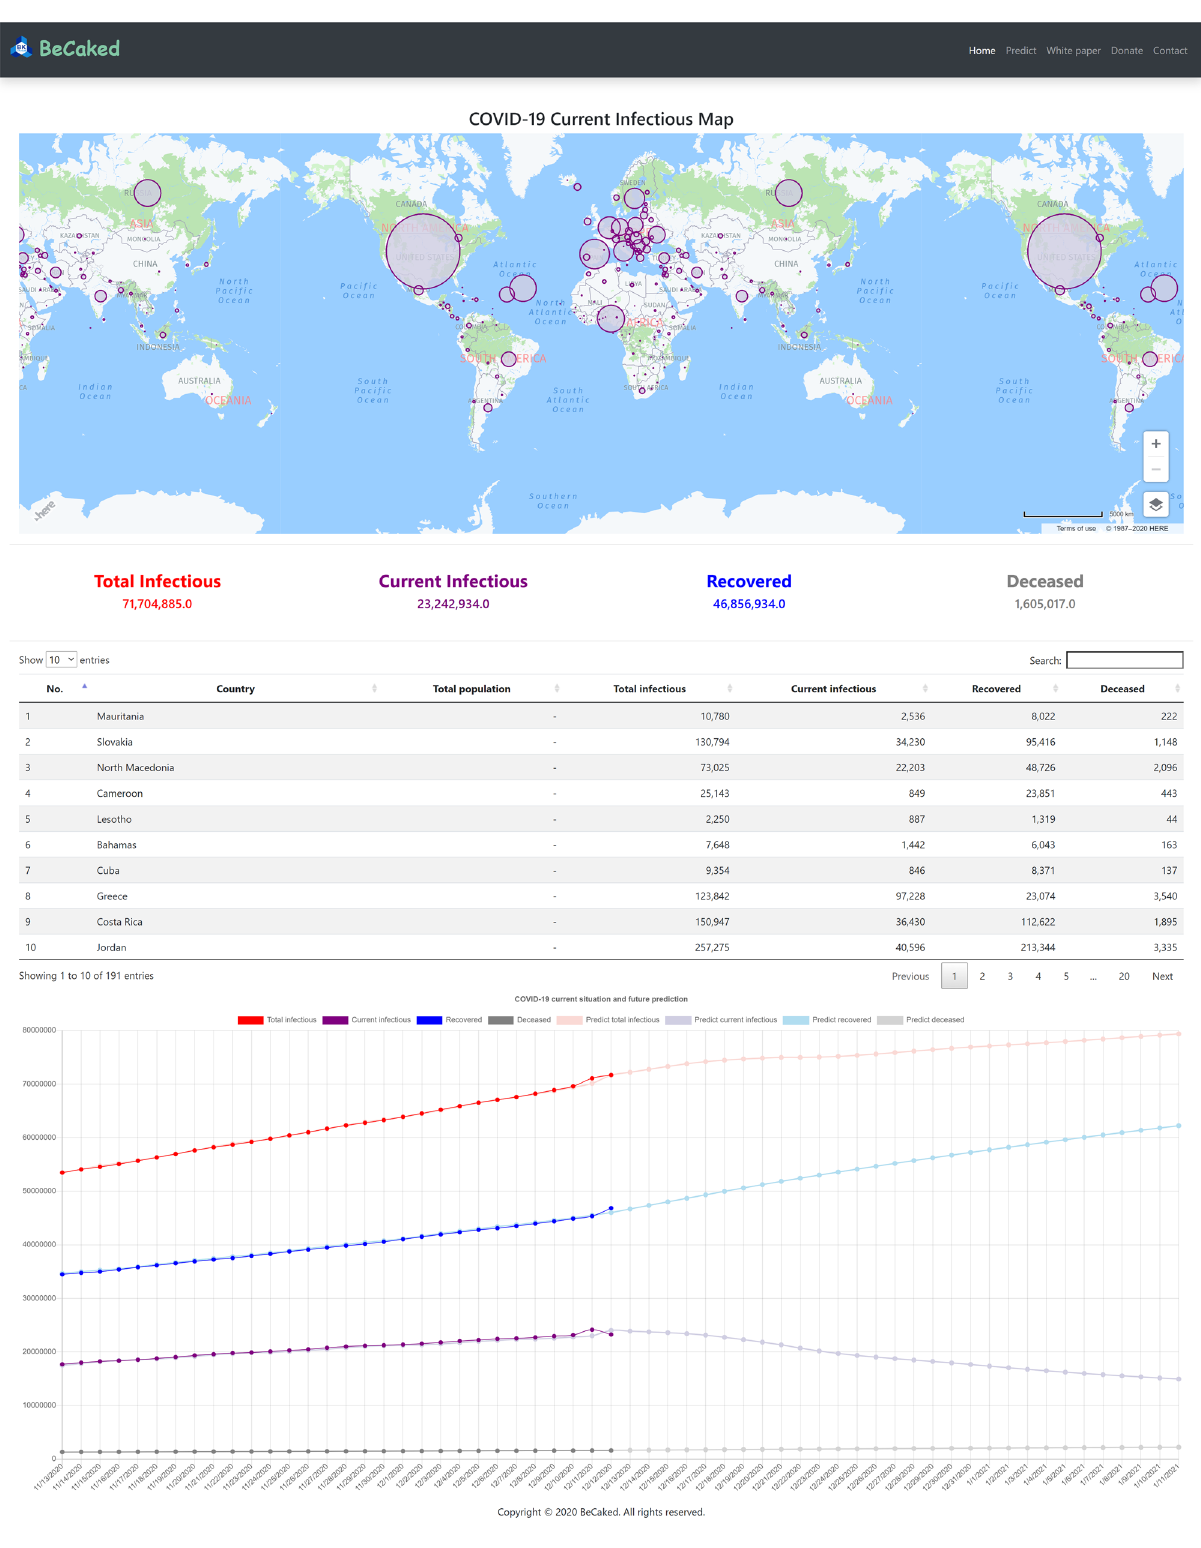
Figure 14. Homepage of the web user interface including COVID-19 map created using HERE Maps 60